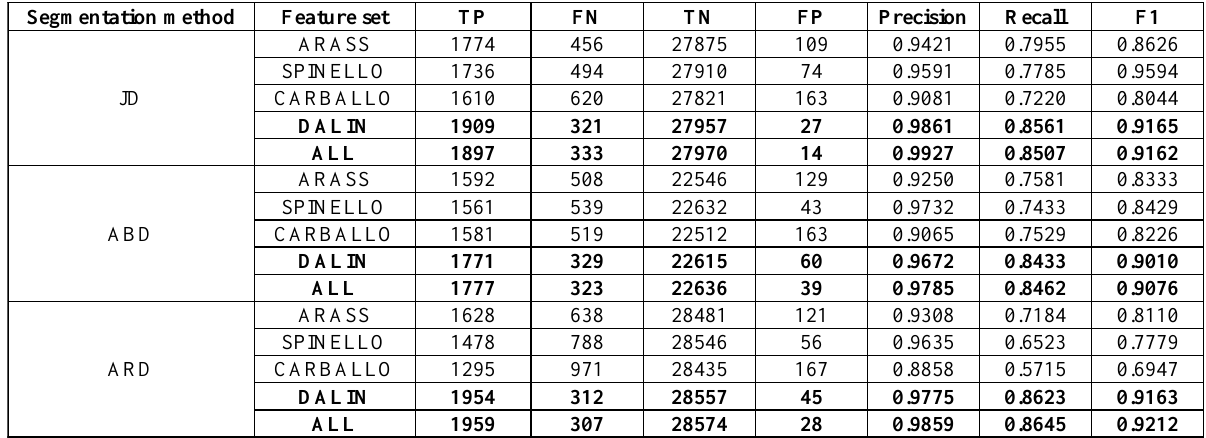
Table 9. Classification results of leg segments by different methods for data set